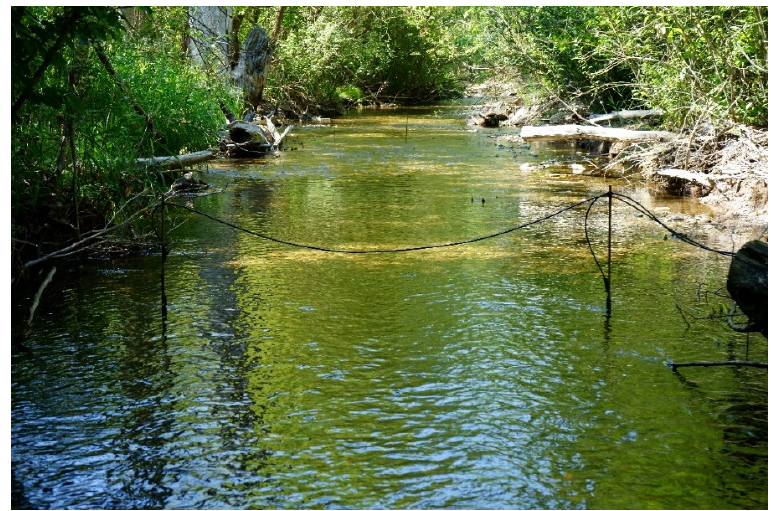
Figure 3. Conductivity sensors in the natural channel, looking upstream.